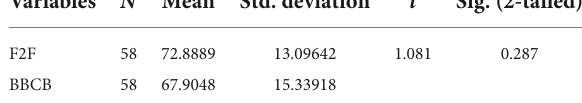
TABLE 6 Students’ perceptions of Blackboard Chatbox (BBCB) in enhancing writing skills. No Item Mean Std.